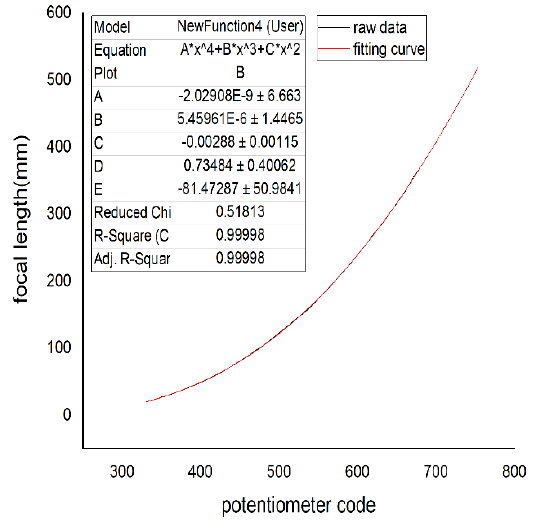
Figure 16. Quartic polynomial fitting.